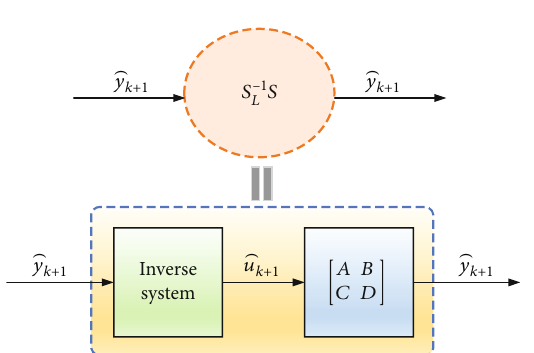
Figure 4: Inverse system of an aeroengine